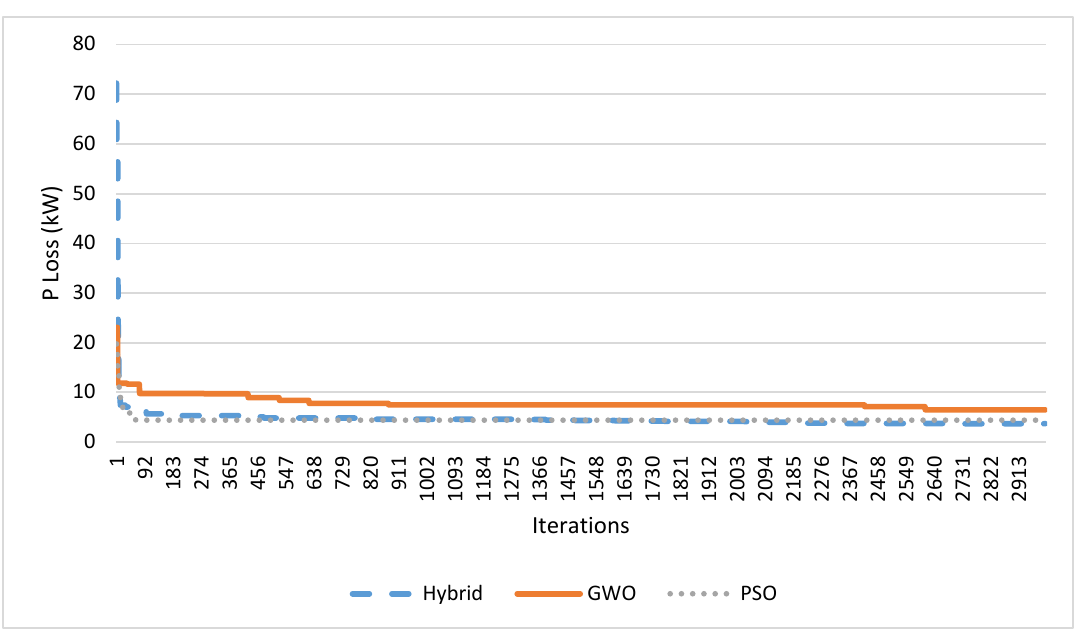
Figure 11. Voltage profile of the 69-bus system using the hybrid technique.